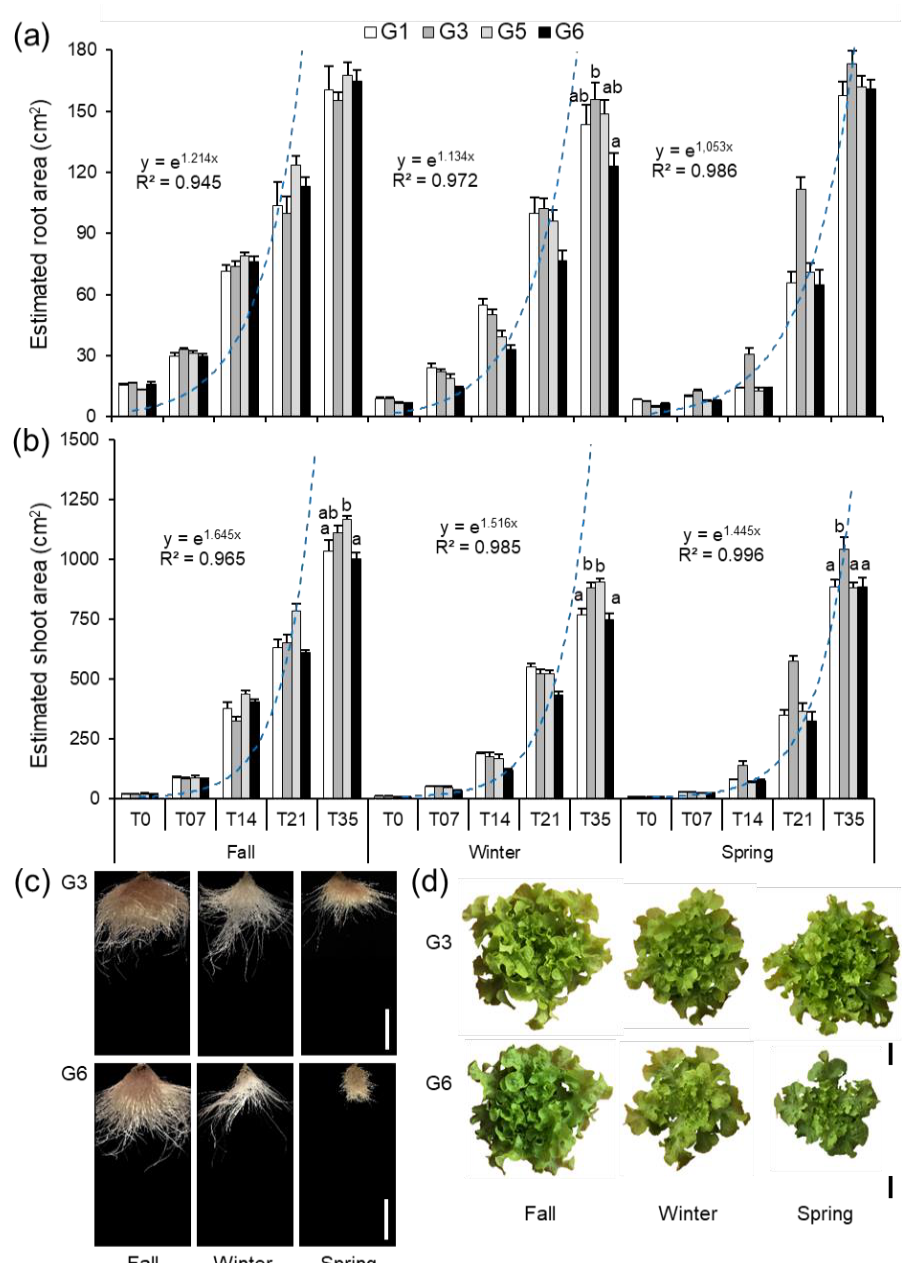
Figure 3. Quantitative analysis of root and shoot area in the studied GOAK genotypes during hydroponic growth. ( a ) Average root area (cm 2 ) and ( b ) average shoot area (cm 2 ) values in the studied lines (G1, G3, G5, and G6) between 0 (T0) and 35 (T35) dap. Theoretical exponential growth curves are depicted in blue. Different letters indicate significant differences at 35 dap (LSD; p -value < 0.01). ( c , d ) Representative images of the root ( c ) and shoot ( d ) system of G3 and G6 genotypes at 14 and 21 dap, respectively. Scale bars: 50 mm.